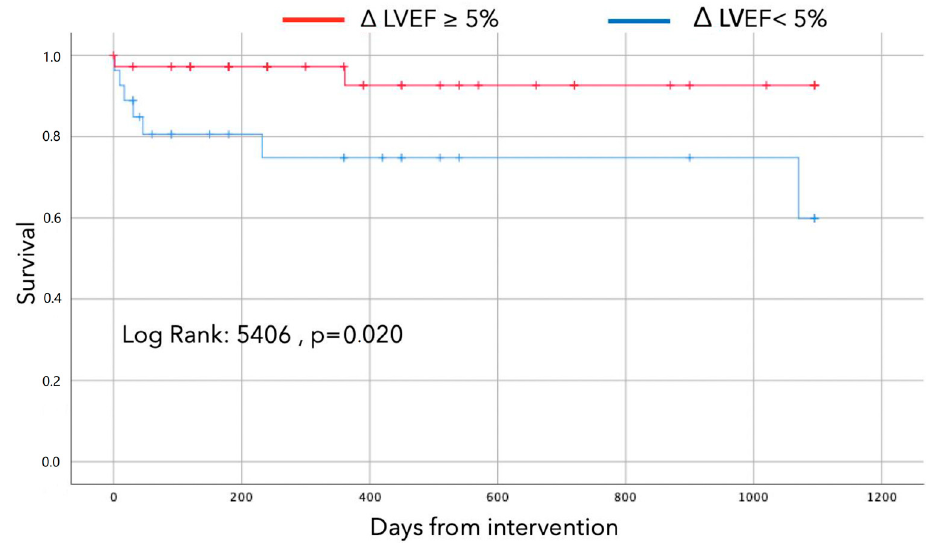
Figure 2. Survival curves according to improvement in LVEF at follow-up of at least